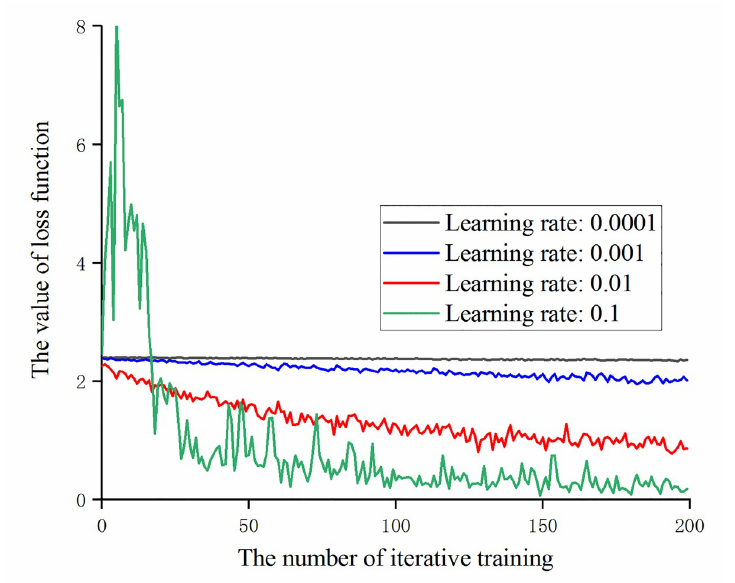
Fig 8. The trend of the loss function value at different learning rates with the number of iterative training.